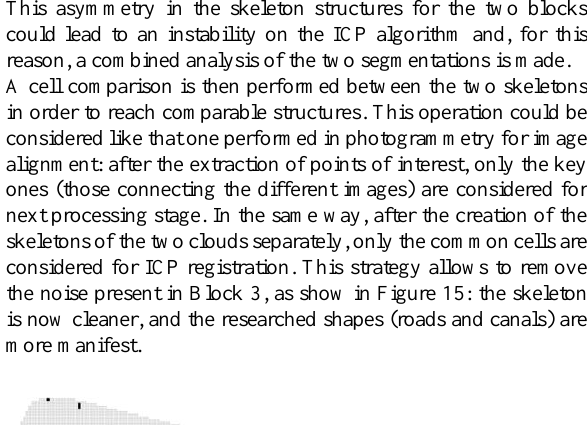
Figure 14. Skeleton structure for Block 4 obtained by point cloud segmentation